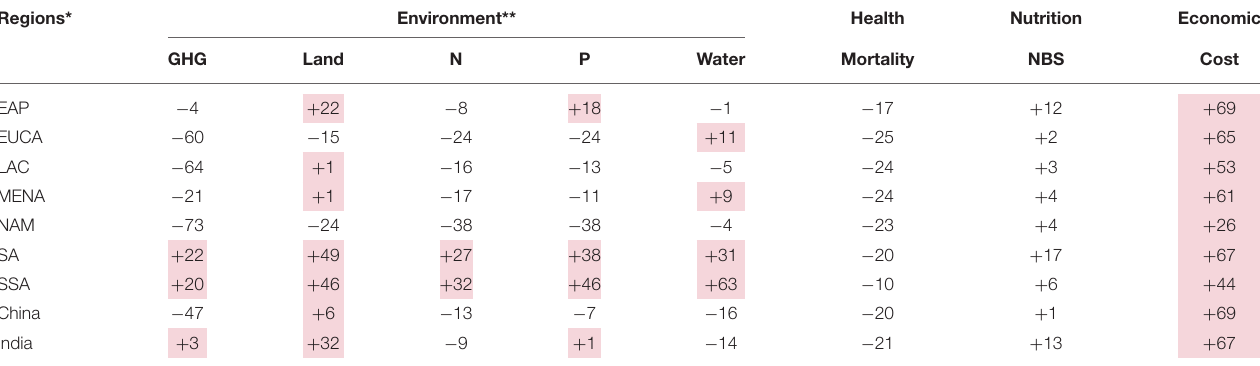
TABLE 1 | Region-specific changes (%) in multiple indicators of sustainability resulting from a transition toward the EAT-Lancet reference diet. Regions* Environment** Health Nutrition Economic Water